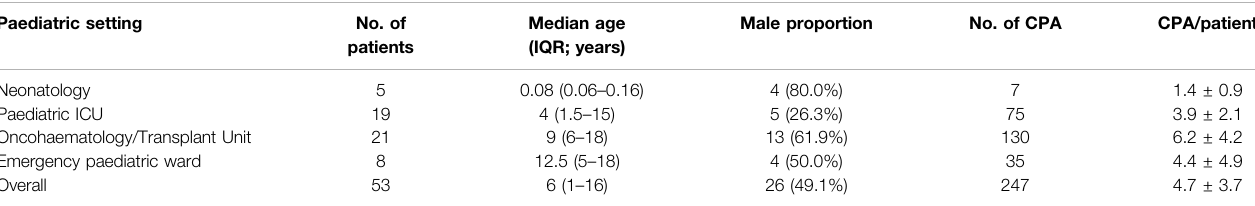
TABLE 3 | Number of clinical pharmacological advice performed in different paediatric settings. Paediatric